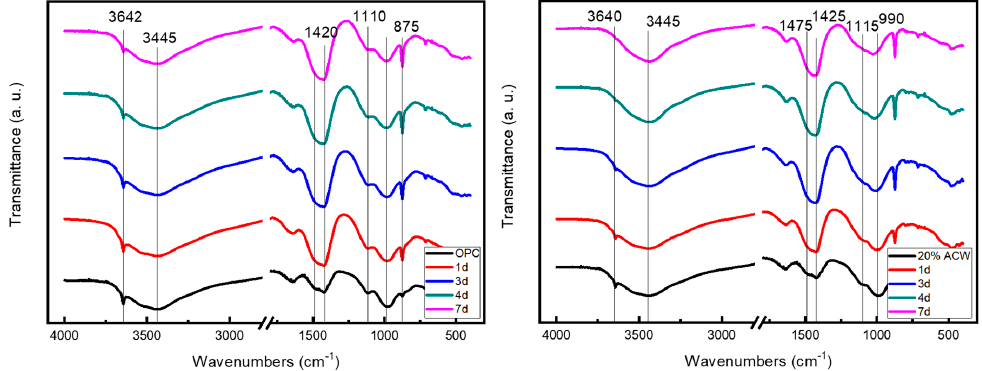
Figure 9. FT-IR spectra by exposure time for OPC ( left ) and 20% ACW ( right ) pastes.